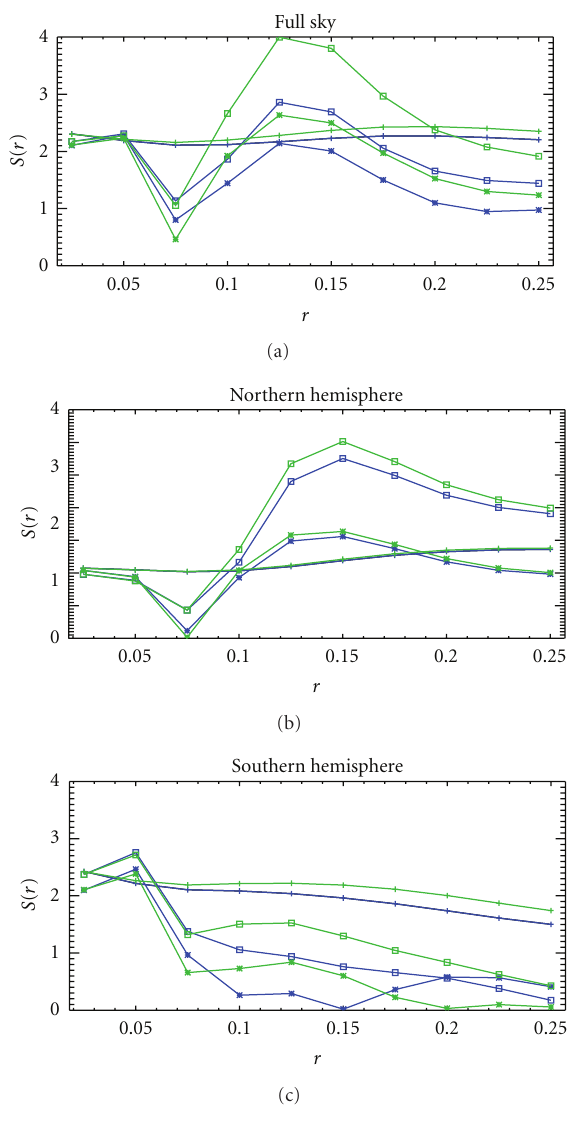
Figure 10: The σ -normalised deviations of the mask-filling method for the original KQ75-mask (blue) and for the modified mask of the previous figure (green) in absolute values, plotted as a function of the scale parameter, whereby as above “+” denotes the mean, “ ∗ ” the standard deviation, and the boxes the χ 2 -combination. The full sky as well as again the single hemispheres is